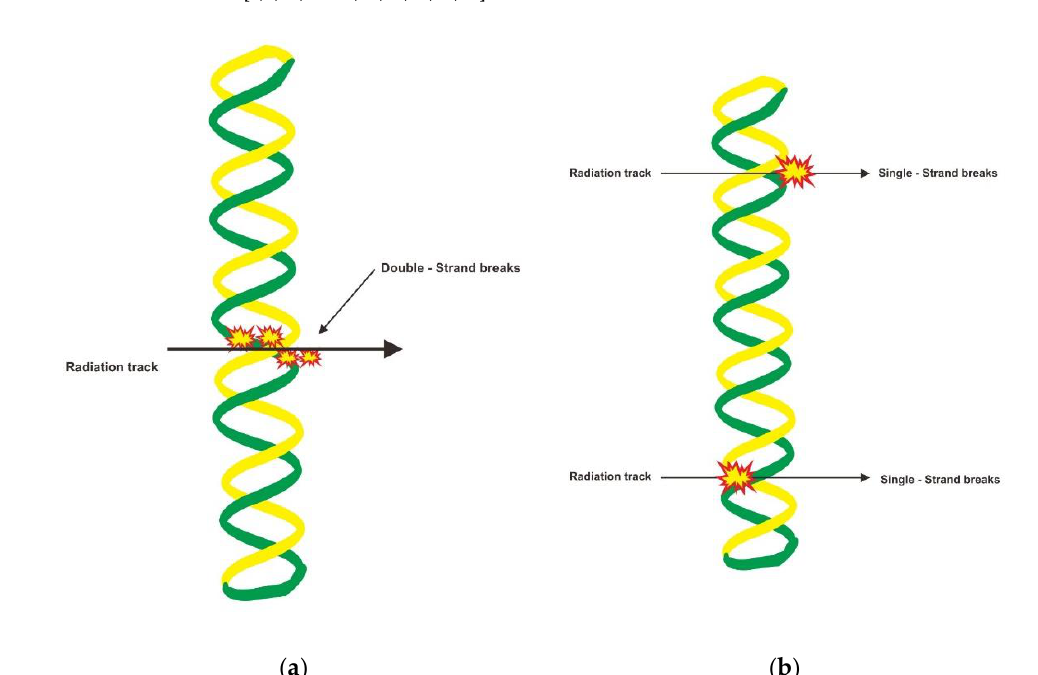
Figure 2. High and intermediate LET radiation (alpha particle and Auger electron, respectively), cause double-strand breaks in DNA ( a ). Single-strand breaks in DNA due to radiation by low LET (beta particle) ( b ).